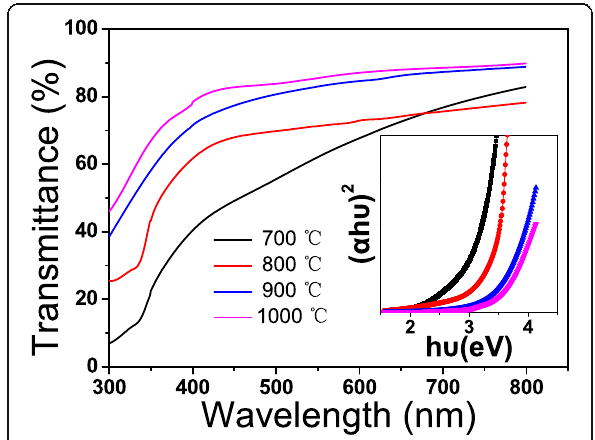
Fig. 4 The optical transmission spectra for CuAlO 2 films annealed at different temperature. The inset shows a plot of ( α h ν ) 2 vs. h ν of the